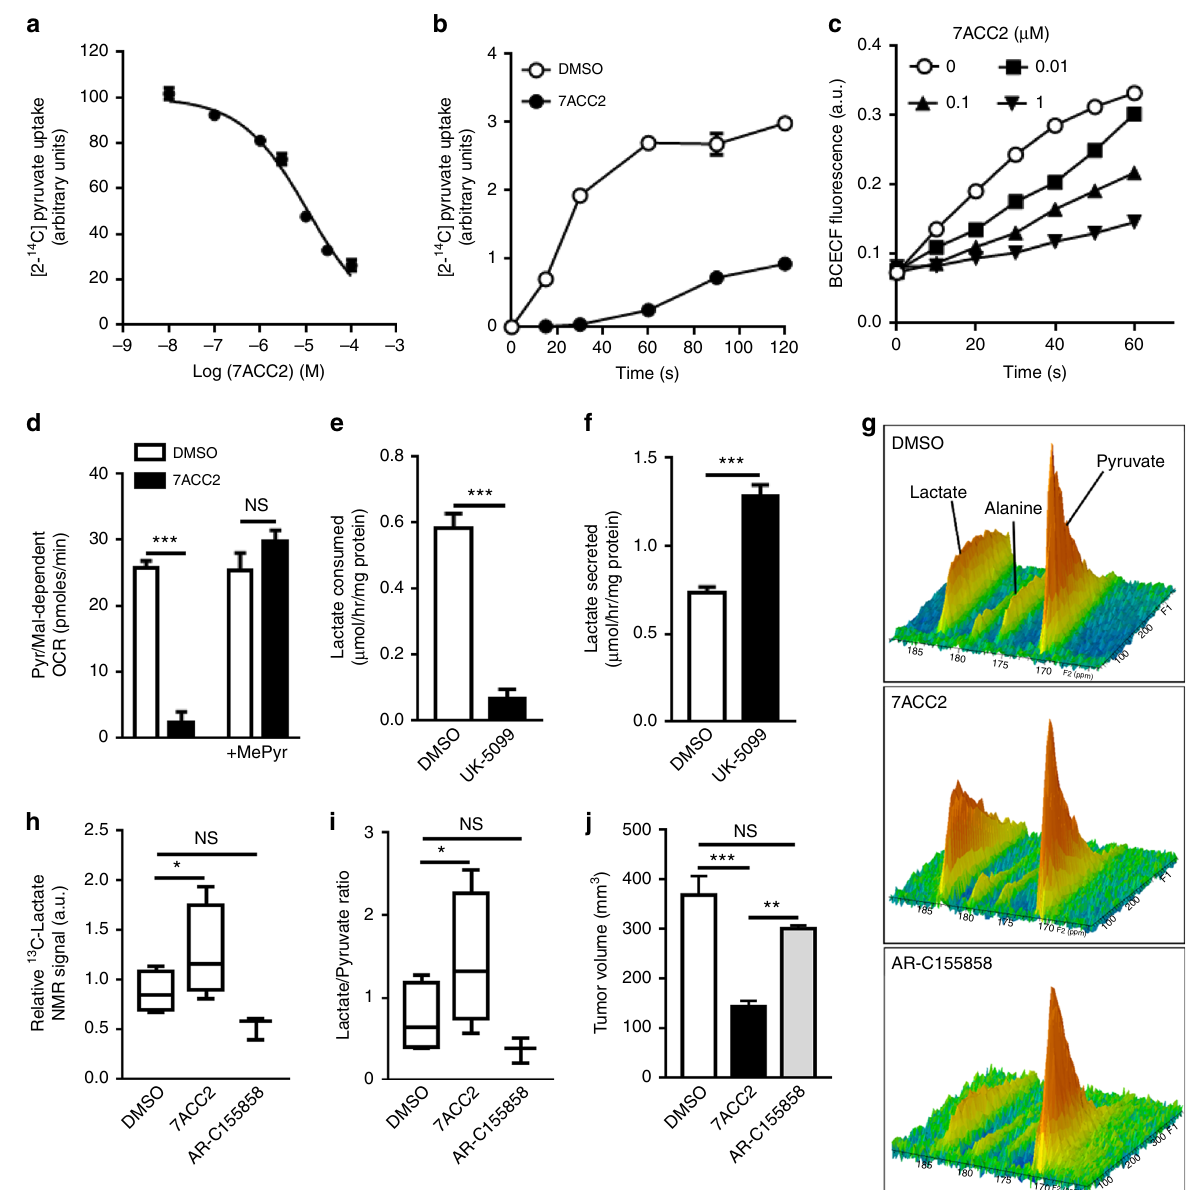
Fig. 4 7ACC2 speci fi cally inhibits mitochondrial pyruvate transport. [2 − 14 C]pyruvate uptake in isolated mitochondria from SiHa cells treated ( a ) with increasing doses of 7ACC2 for 2 min or ( b ) with 10 µ M 7ACC2 for increasing periods of time. c BCECF fl uorescence re fl ecting progressive changes in pH within isolated SiHa cell mitochondria treated with increasing doses of 7ACC2. d Effects of 10 µ M 7ACC2 on OCR measurements using isolated SiHa cell mitochondria exposed to pyruvate/malate with or without methylpyruvate. e Lactate consumption and ( f ) secretion by SiHa cells incubated for 24 h with 10 µ M UK-5099 in lactate or glucose-containing medium, respectively. g Representative 13 C-MRS spectra acquired in vivo from treated and untreated SiHa tumor xenografts after hyperpolarized 13 C-pyruvate injection. h Relative 13 C-lactate NMR signals and ( i ) modi fi cations in the 13 C lactate/pyruvate ratio after treatment with 3 mg/kg 7ACC2 or AR-C155858 for 2 h ( n = 3 for each group). j Tumor volume of SiHa xenografts in nude mice after 9-day treatment with 3 mg/kg 7ACC2 or AR-C155858 ( n = 5 for each group). Data are represented as mean ± SEM of three independent experiments (with ≥ 6 technical replicates). Signi fi cance was determined by Student ’ s t -test ( e , f ), one-way ANOVA ( h – j ) or two-way ANOVA ( d ) with Bonferroni multiple-comparison analysis. * p < 0.05; ** p < 0.01; *** p < 0.001; NS, not signi fi